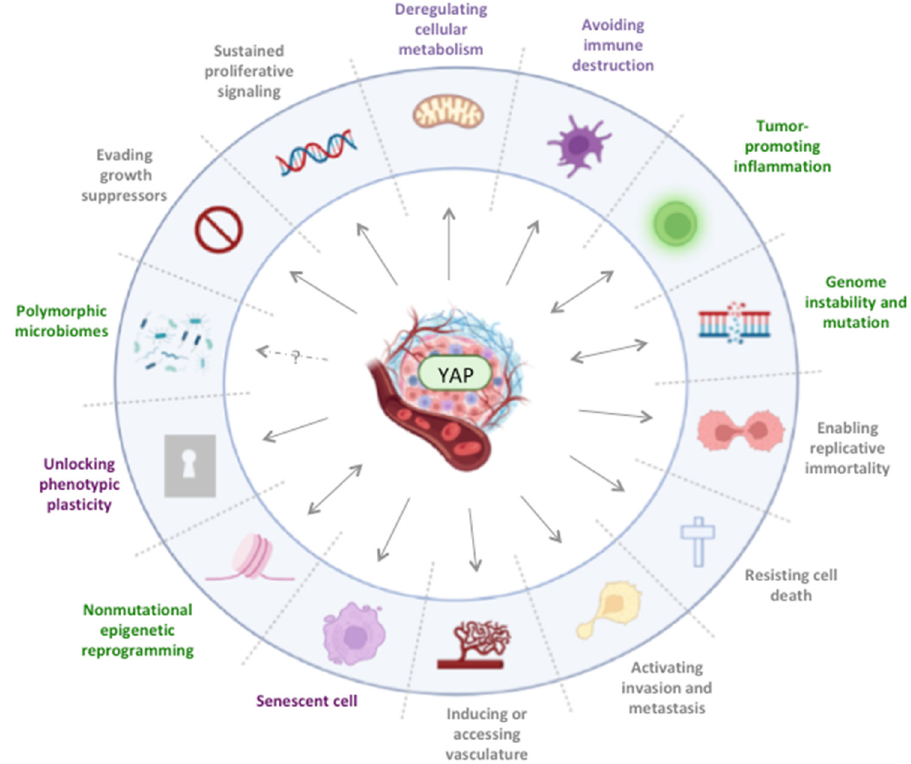
Figure 2. YAP and the Hallmarks of